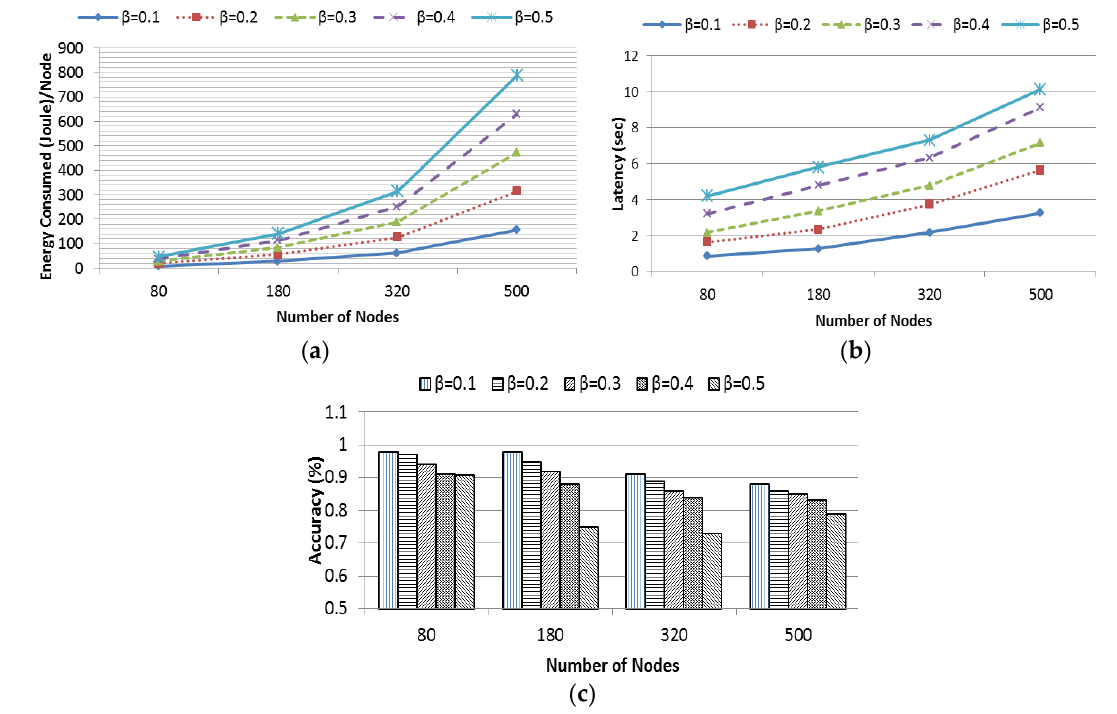
Figure 14. ( a ) Energy consumption; ( b ) latency; and ( c ) accuracy.